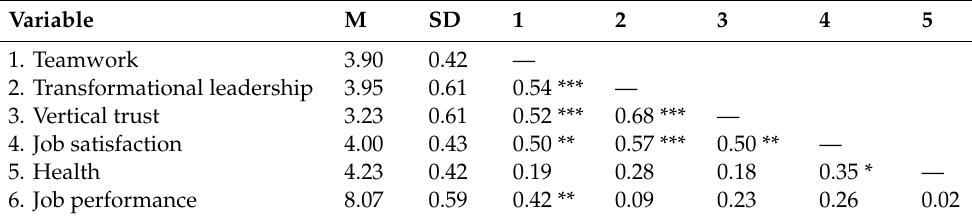
Table 3. Intercorrelations between the study variables (Level